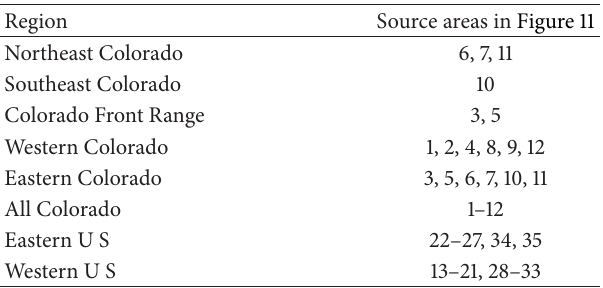
Table 5: Individual source areas included in each of the regions in Table 4. See Figure 11 for a map of the